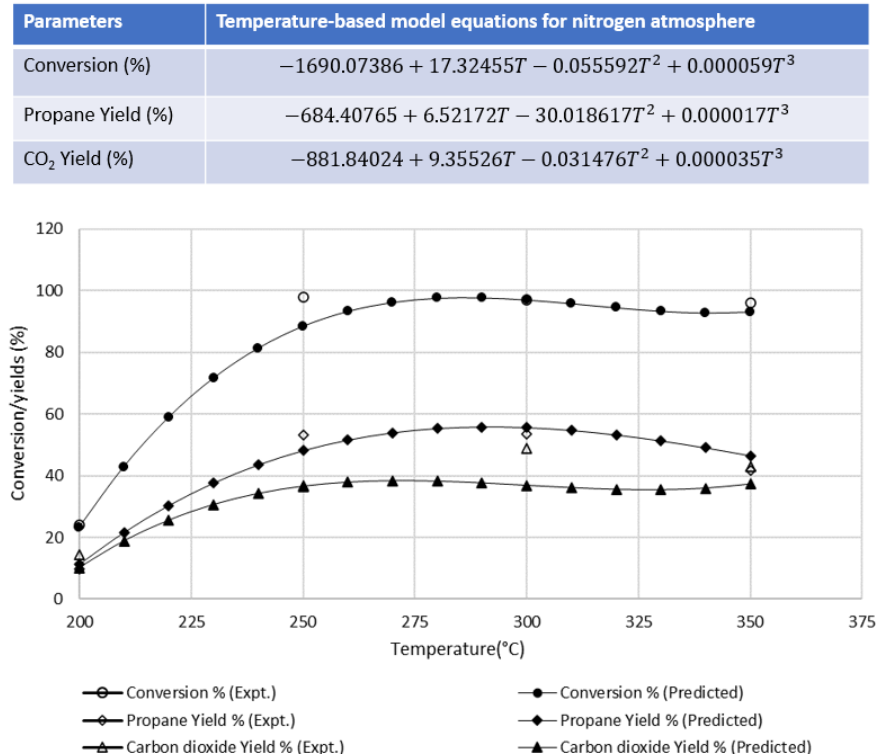
Figure 2. Comparisons between experimental and temperature-based model equations on butyric acid conversion and yields of propane and CO 2 under initial nitrogen pressure of 5 bar.